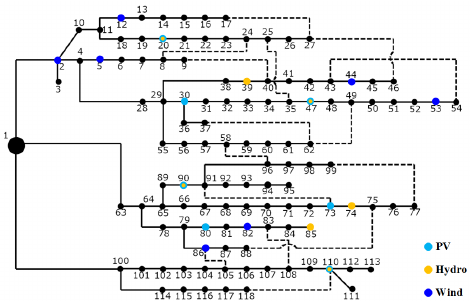
Figure 5. Electrical bus system-118. Table 6. Comparison results of islanding detection for the 118 bus